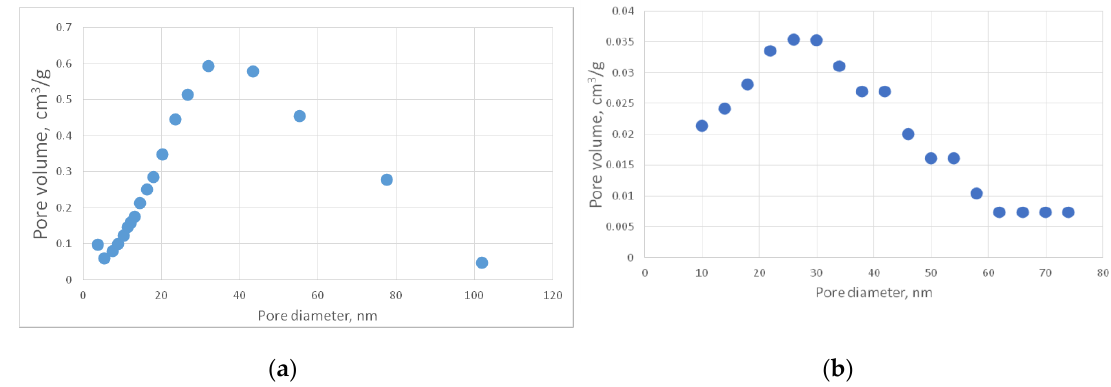
Figure 16. Di ff erential ( a ) and recalculated ( b ) pore size distribution curves of the PA-C sample. Figure 16. Differential ( а ) and recalculated ( b ) pore size distribution curves of the PA-C sample. Table 3. Measured characteristics of the PA-C